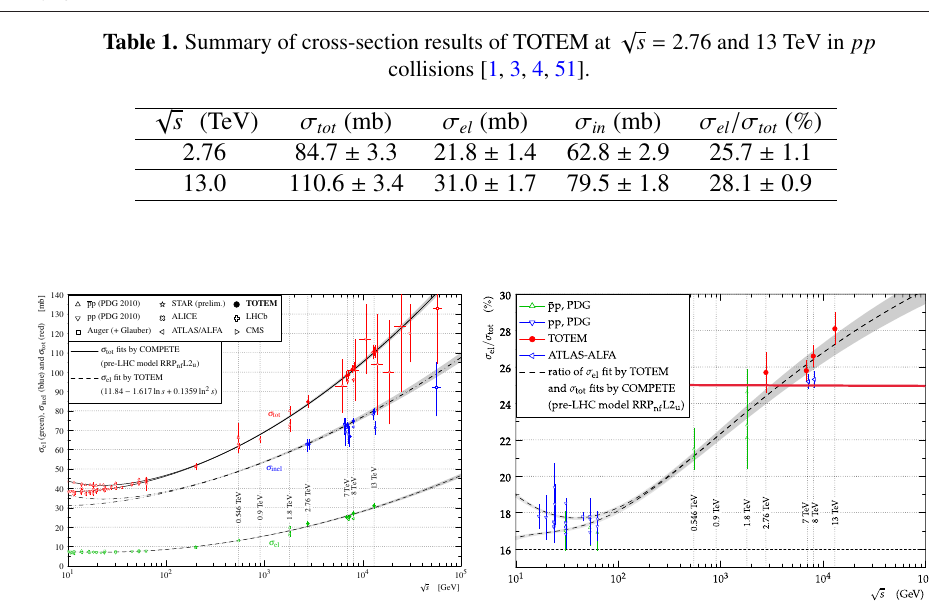
Figure 4. Left panel: The total, elastic and inelastic cross-sections as measured at various LHC energies and below. The total cross-section at √ s = 13 TeV is determined with ρ = 0 . 1 at this energy. Overview of total ( σ tot ), inelastic ( σ el ) and elastic ( σ el ) cross-sections for pp and pp collisions as a function of √ s , including TOTEM measurements over the whole energy range explored by the LHC. Uncertainty band on theoretical models and / or fits are described in the Legend. The continuous black lines (lower for pp , upper for pp ) represent the best fits of the total cross section data by the COMPETE collaboration. The dashed line results from a fit of the elastic scattering data. The dash-dotted lines refer to the inelastic cross section and are obtained as the di ff erence between the continuous and dashed fits. From refs. [1, 2]. Right panel: The elastic to total cross-section ratio increases with increasing energies, as indicated on this Figure from ref. [1]. At the LHC energies between 8 and 13 TeV it crosses significantly the important limit of (1 + ρ 2 ) σ el /σ tot = 1 / 4. It is important to note that this ratio reaches 0 the critical value in the region of √ s = 2 . 76 7 TeV and it clearly exceeds it at √ s = 13 TeV. The best − COMPETE fit suggests a threshold behaviour in the region of √ s = 2 . 76 - 4